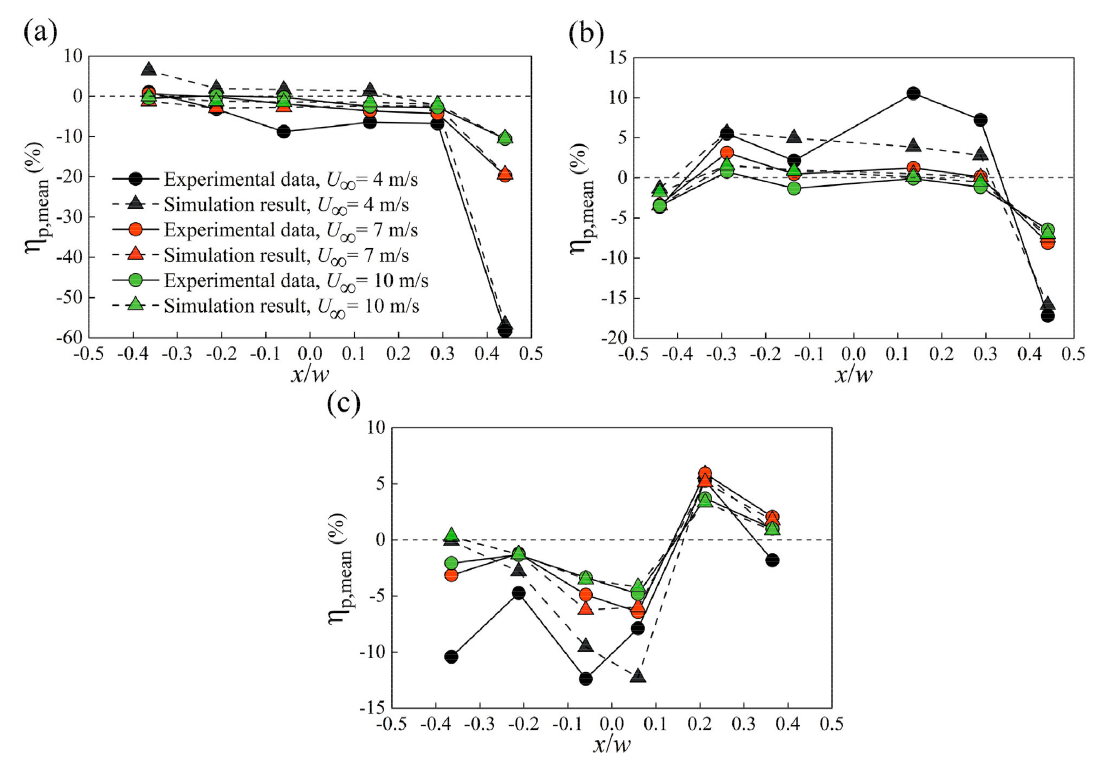
Figure 6. Mean pressure coe ffi cient change rates along the roof centerline: ( a ) case A with the wall-jet direction from the trailing edge to the leading edge; ( b ) case B with the wall-jet direction from the middle of the roof to the leading and trailing edges; ( c ) case C with the wall-jet direction from the leading and trailing edges to the middle of the